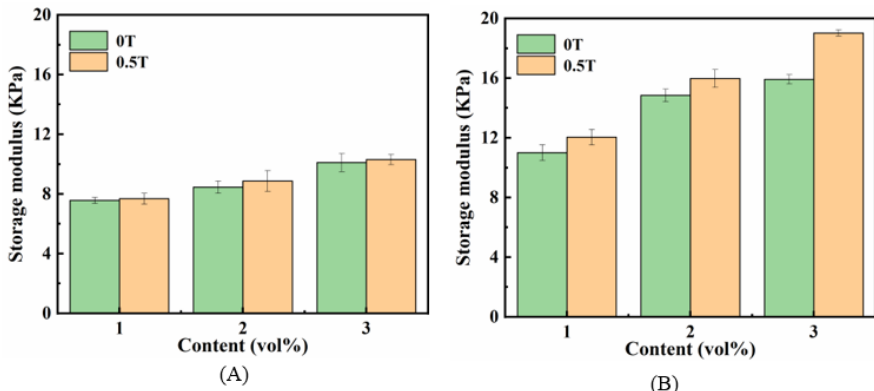
Figure 5. Effects of the contents of Fe3O4 on the G’ of isotropy ( A ) and anisotropy ( B ) samples within LVE region (f = 10 rad/s, B = 0 T and 0.5 T).